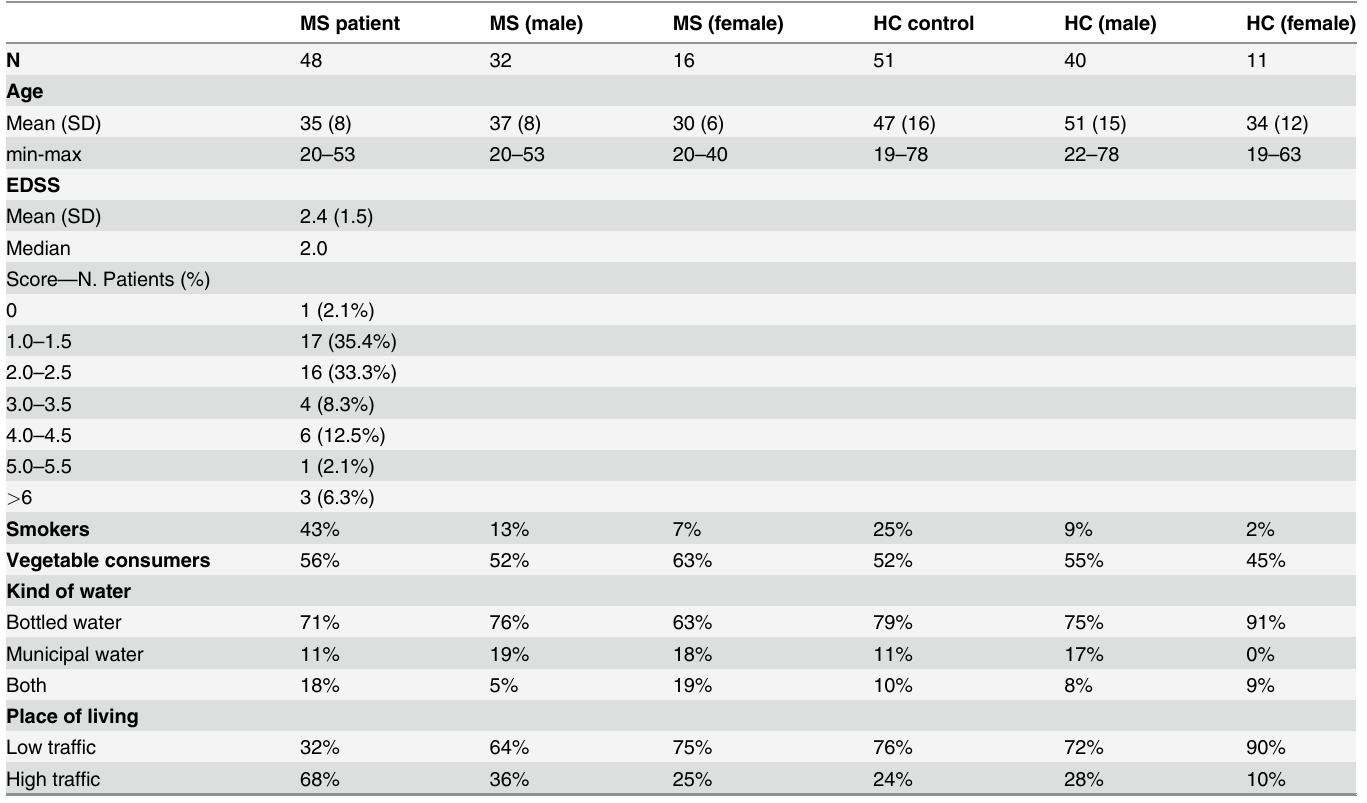
Table 1. Biographical and clinical